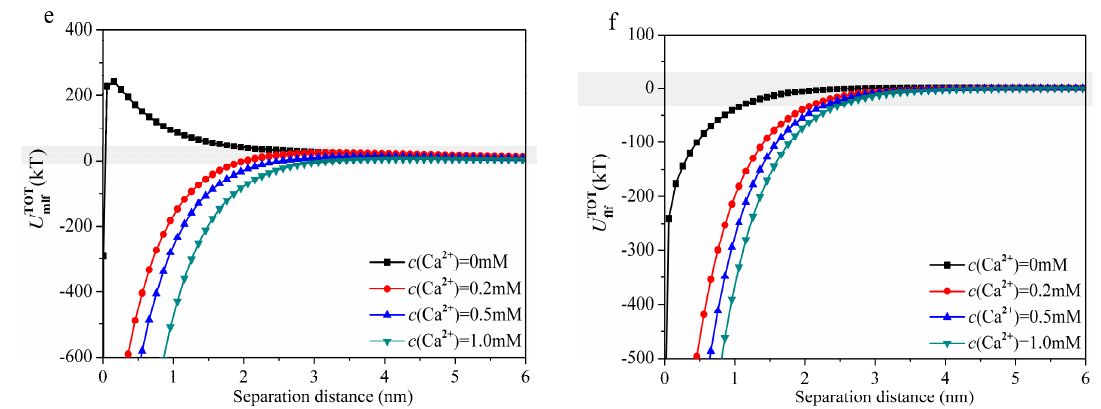
Figure 2. Variations in interaction energies of membrane–foulant and foulant–foulant with separation distance at different solution conditions: ( a , b ) pH; ( c , d ) IS; ( e , f ) Ca 2+ concentration.